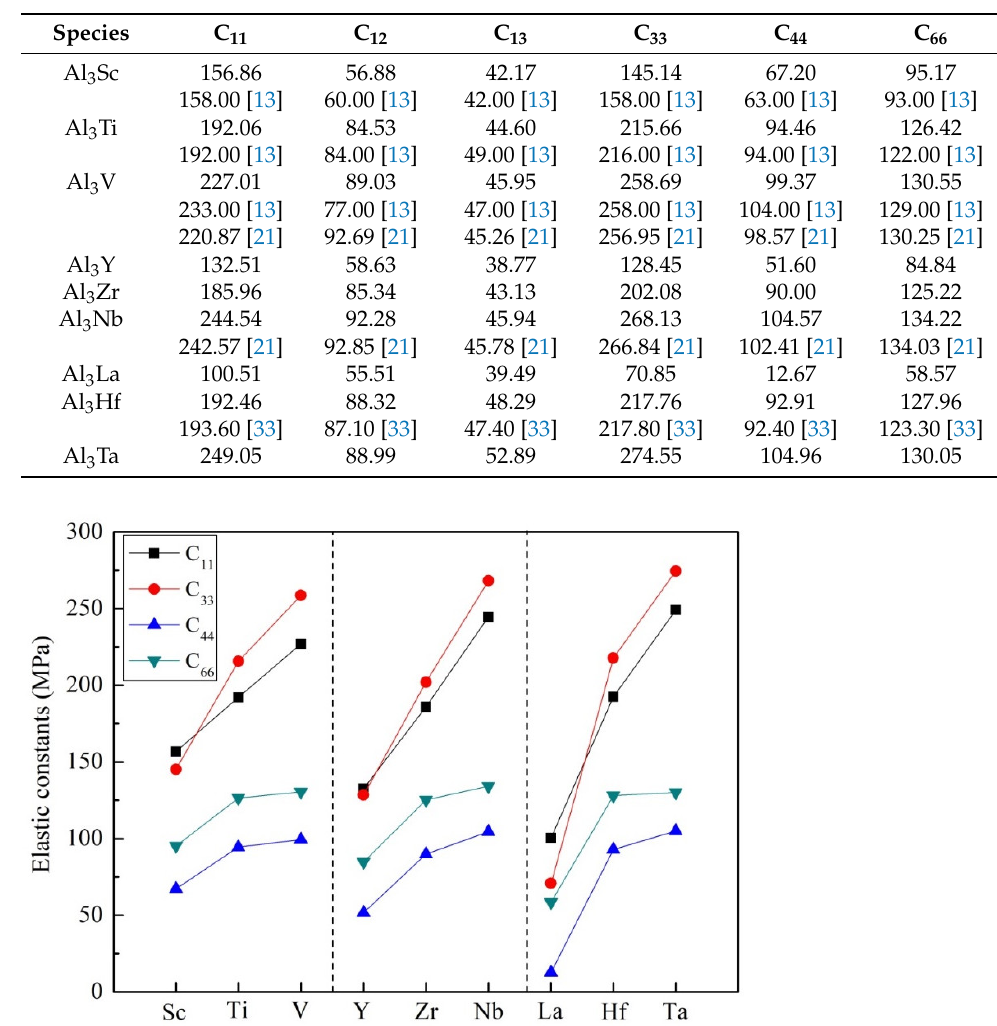
Table 2. The calculated elastic constants Cij (GPa) of Al 3 TM compounds.